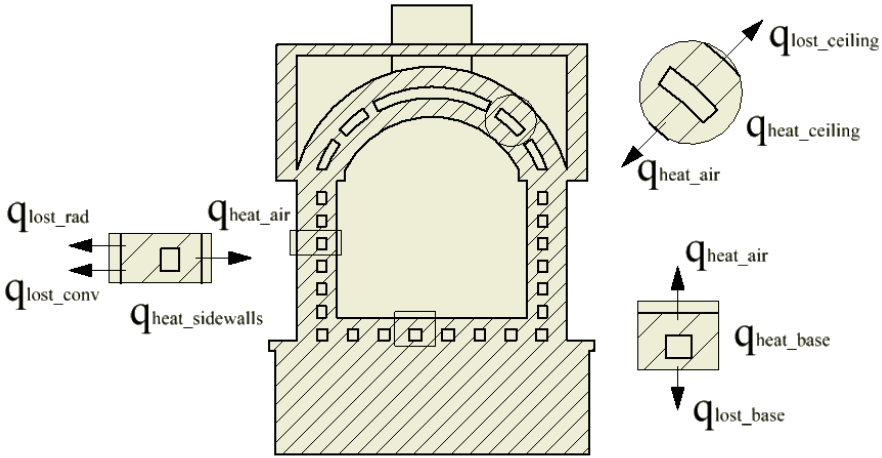
Figure 3. View of the kiln and control volumes in the sidewalls, base, and ceiling of the equipment.